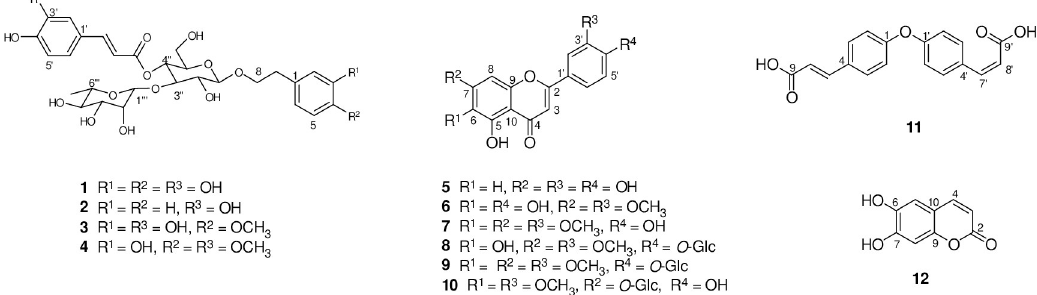
Fig 4. The structures of compounds 1–12 isolated from the ethyl acetate fraction (EAF) of C . cyrtophyllum leaves.